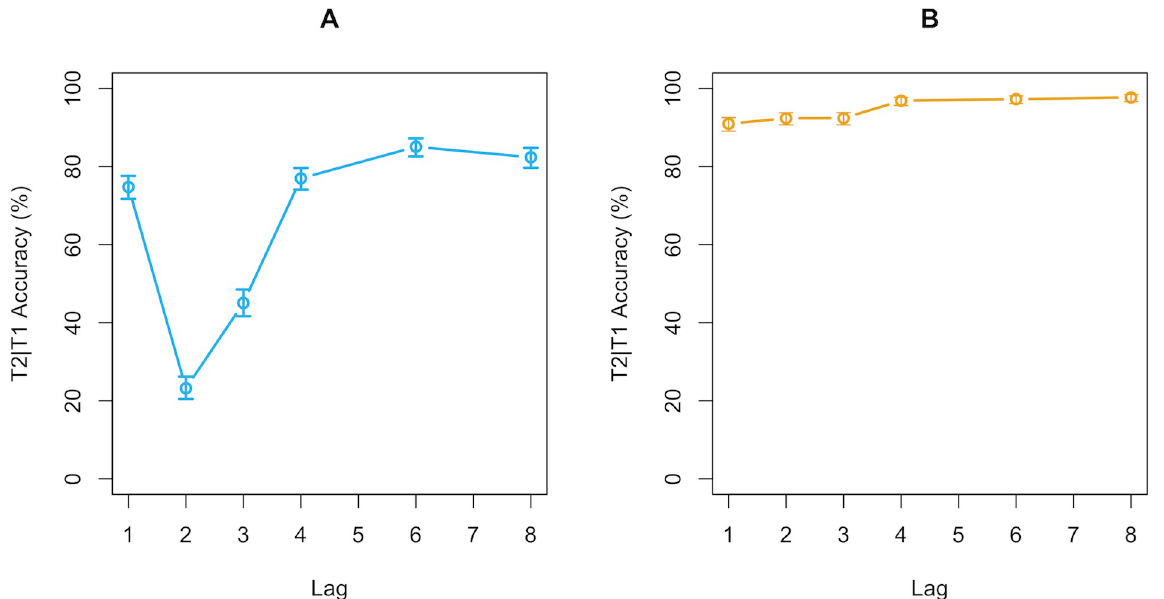
Fig 6. Model predictions for both version of the modified AB model. The predictions of the ‘consolidate-separate’ version of the model include a mostly standard AB with the deepest point at lag 2 (a). The predictions of the ‘consolidate-chunked’ version include no AB and a very high overall performance level (b). Confidence intervals were calculated using the Agresti-Coull method